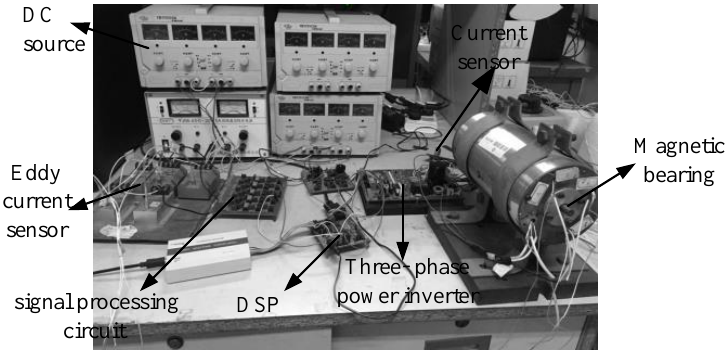
Figure 8. Experimental system of the three-pole radial Figure 8 . Experimental system of the three-pole radial HMB.